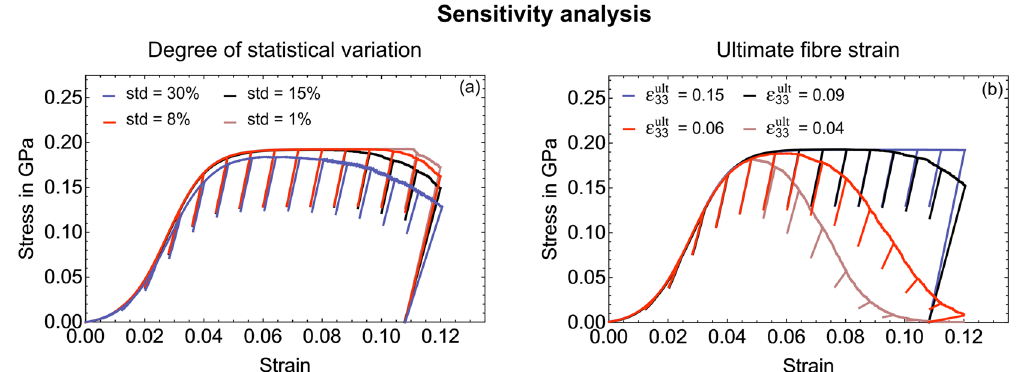
Figure 7. Sensitivity analysis of the elasto-plastic fibre model. ( a ) Influence of the amount of statistical variation of material properties (micro- and nanomechanical heterogeneity): A standard deviation of 15% for the normal distributions was used as a base value (see Methods section "Statistical material properties") and varied between 1 and 30%. ( b ) Influence of ultimate strain values (base value 0.09) (see Methods section "Model parameters" including Table